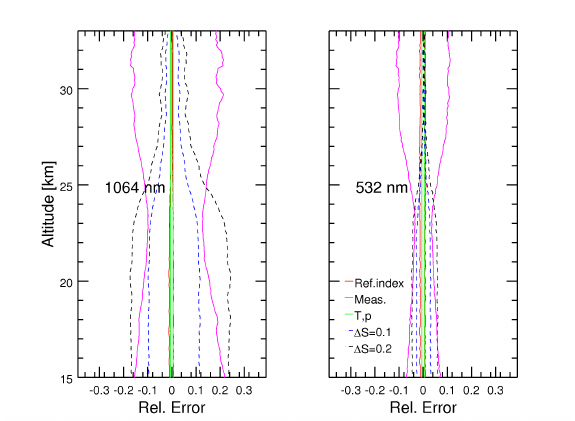
/ k sca ) at the two wavelengths 1064nm Mie Mie